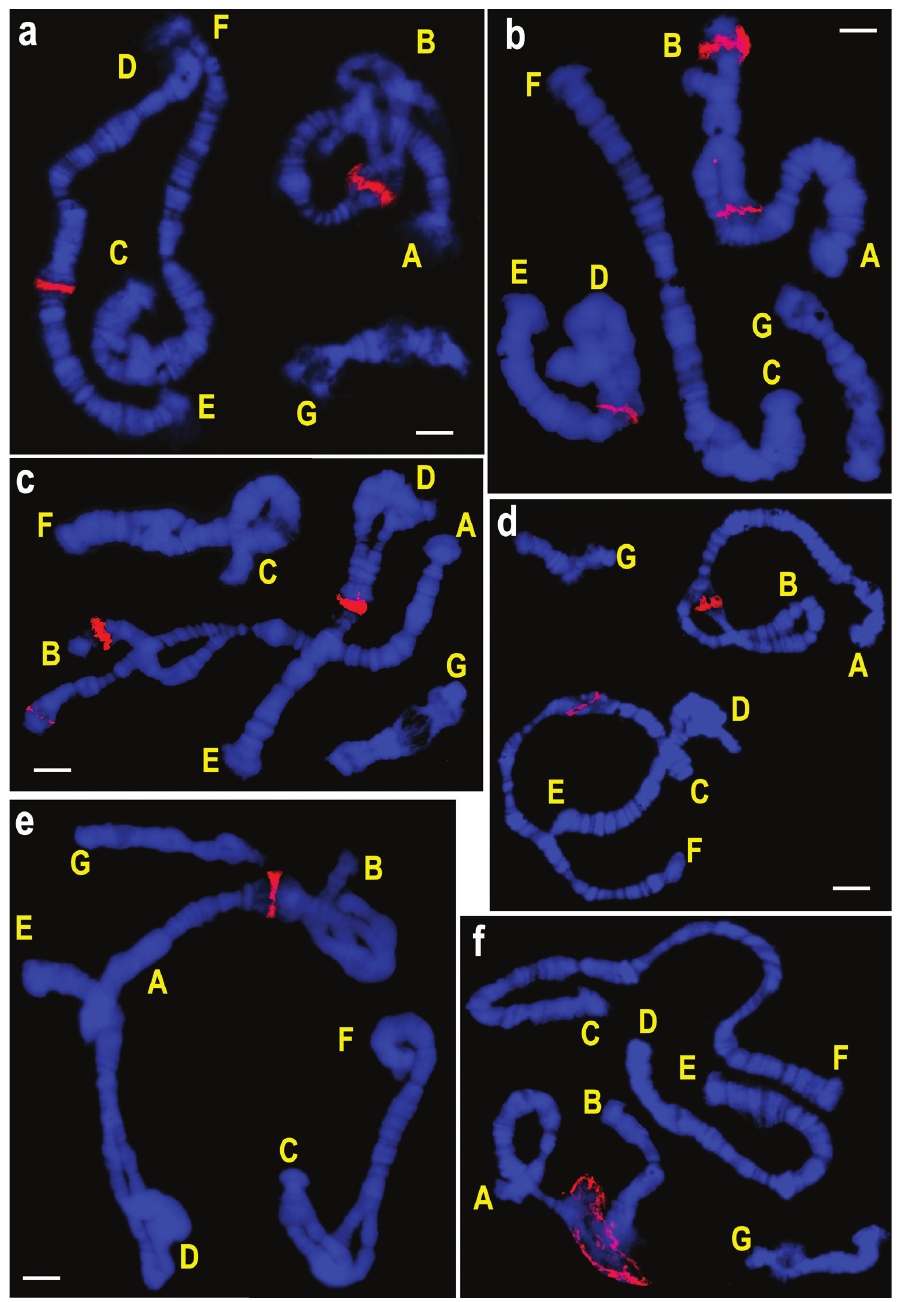
Figure 4. FISH of rDNA probes on polytene chromosomes of species from the subgenus Camptochi- ronomus. a–c C. tentans , where b and c specimens with heterozygous inversions in arm B that change the position of NOR in one of the homologues d C. dilutus; e C. pallidivittatus f C. setivalva . Letters designate chromosomal arms. Bar = 10